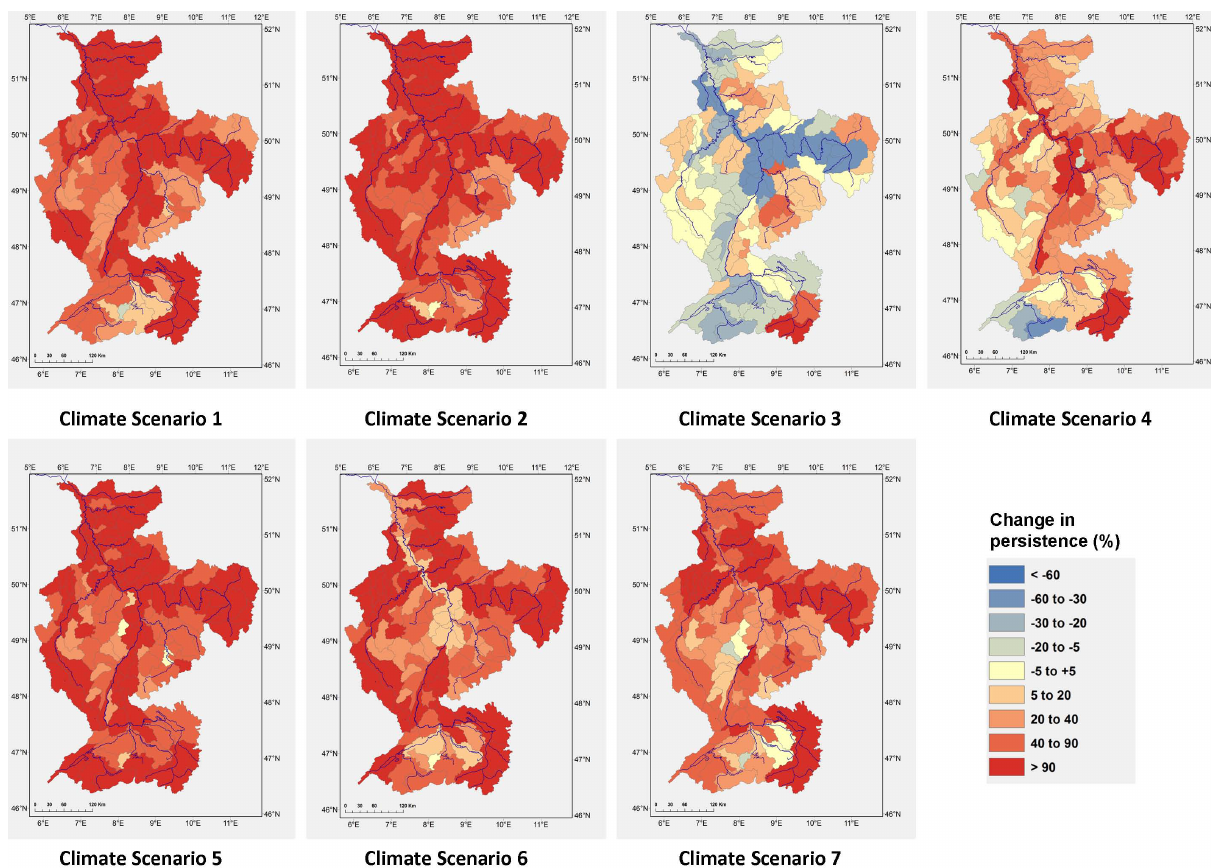
Fig. 7. Relative change (%)* in low flow persistence in 134 sub-catchments based on simulated low flows using simulated inputs from seven climate scenarios for the future period 2063–2098 (case 4) compared to simulated low flows using simulated inputs for the reference period 1964–2007 (case 3). * (Future period – Current period)/Current